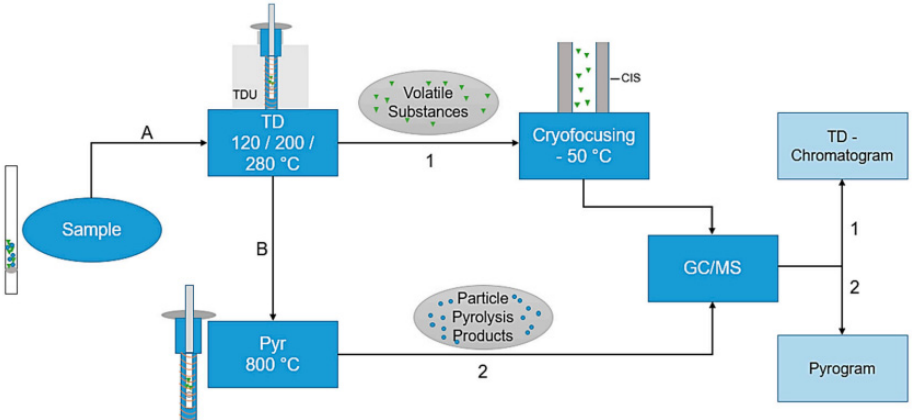
Figure 11. TD-Pyr-GC/MS analysis flowchart. To begin, the sample is thermodesorbed (120–280 °C), desorbing volatile compounds and cryofocusing them in the Cooled Injections System (CIS) at 50 °C. Following that, the sample is transferred to a GC column for MS analysis (TD-GC/MS). The identical sample (B) is then pyrolyzed at 800 °C and analyzed by GC/MS (Pyr-GC/MS). The TD-chromatogram and the pyrogram are used to conduct the assessments. Ref [132] Reproduced with permission from Reichel et al., Molecule; published by MDPI, 2020.